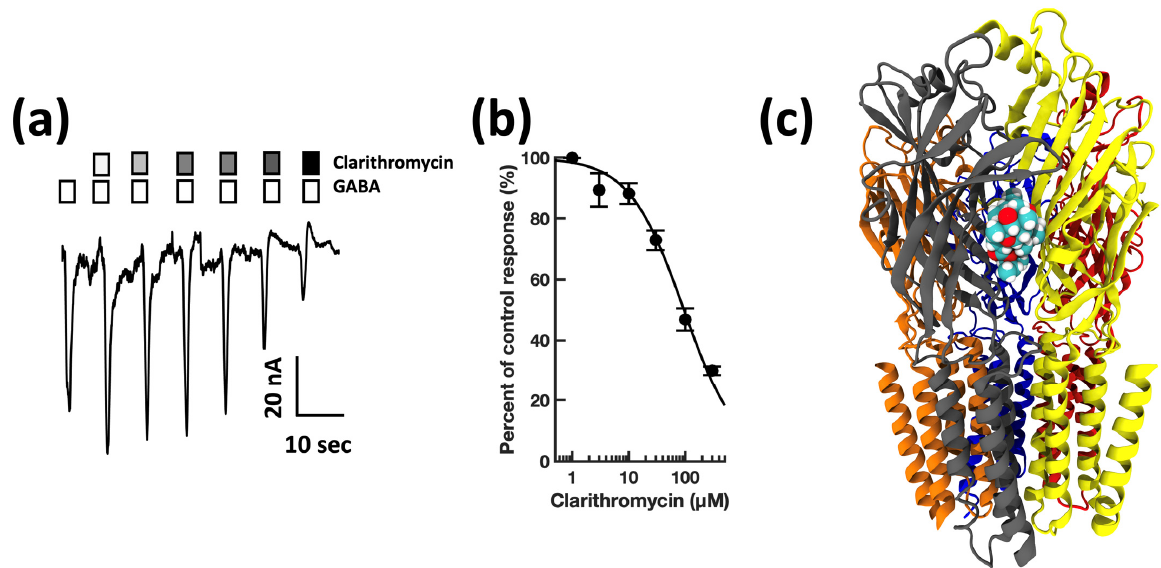
Figure 3. Clarithromycin inhibits GABA A receptor activation in a concentration-dependent manner, and preferentially docks at the α + β -Interface in a pocket defined by canonical loops A-F. ( a ) Rep- resentative microfluidic ensemble whole cell recording from HEK293 cells expressing rat α 1 β 2 γ 2s GABA A receptors. Open bars above the current trace indicate the duration of GABA application. Shaded bars indicate the duration of clarithromycin application. Darker shading indicates increased concentration. The concentrations applied were 1, 3, 10, 30, 100, and 300 μ M clarithromycin. Cali- bration bars indicate the current amplitude and duration in nA and seconds. ( b ) Clarithromycin concentration response relationship for GABA receptor modulation. Each point is plotted as mean ± standard error of the mean for 20–24 determinations. ( c ) The clarithromycin binding pocket is predicted to be defined by the α (loops A and C, and the β 1 β 2 turn) and β (Loops D, F) subunits. Color key: α subunit (red and grey), β subunit (yellow and orange), γ subunit (blue).